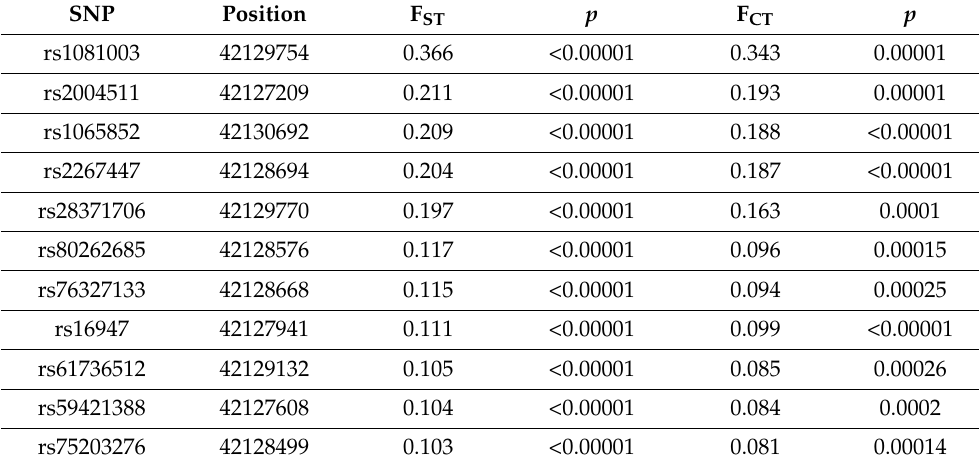
Table 2. List of 11 single nucleotide polymorphisms (SNPs) of the CYP2D6 gene which show inter- population differentiation (F ST ) above 0.1. F CT defines the proportion of total genetic variability among continental